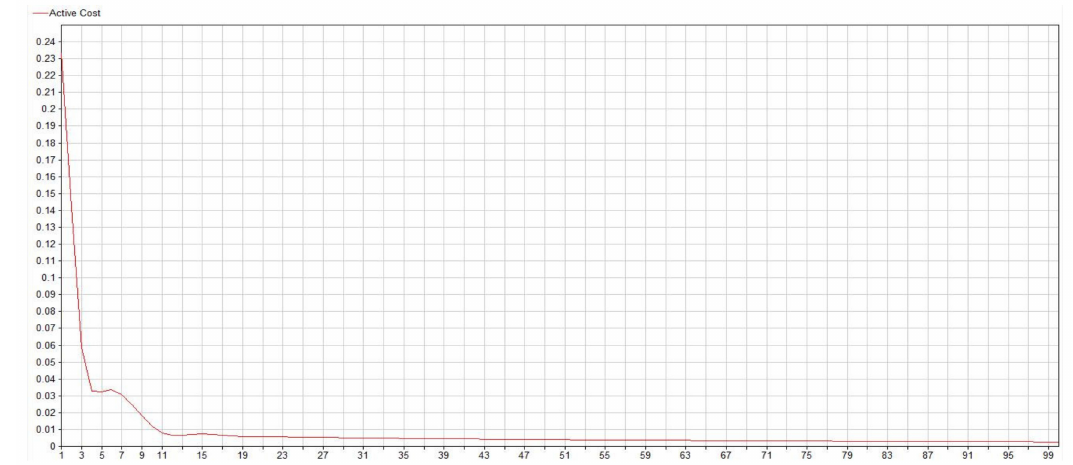
Figure 5. The best cost per iteration via the ANN-GFFN algorithm.